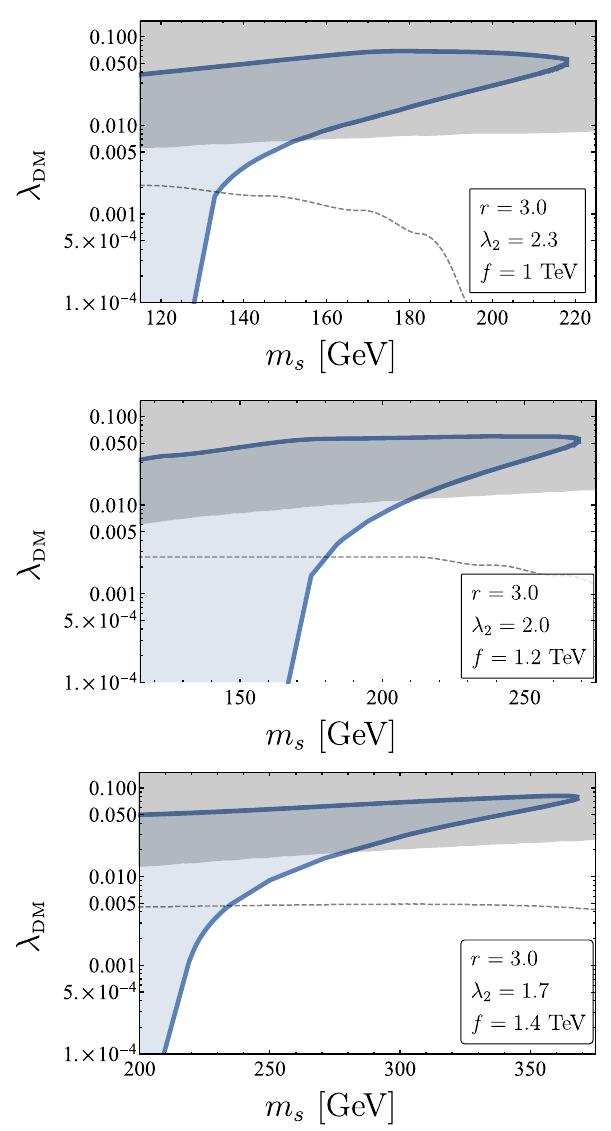
Fig. 6 Singlet relic abundance in the m s ,λ DM plane for f = 1 TeV (left), f = 1 . 2 TeV (middle) and f = 1 . 4 TeV (right), for fixed r = 3 and minimal λ 2 ∼ 2300 GeV . The solid blue lines represent areas where f (cid:10) = (cid:10) (cid:10) > (cid:10) s s DM . The blue areas are regions where DM , and there- fore are excluded. The grey regions are excluded by XENON1T [59] after 34.2 live days. The Dashed lines are the projected sensitivities for XENON1T at 1 . 1yrs × Ton[60]